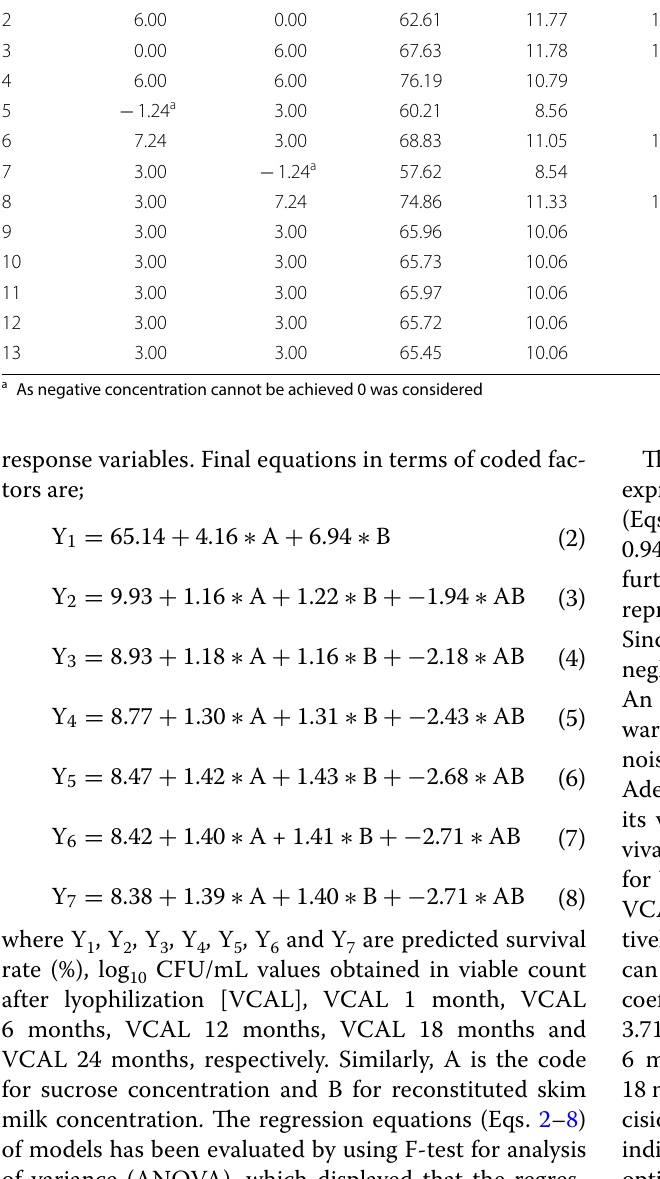
a As negative concentration cannot be achieved 0 was considered